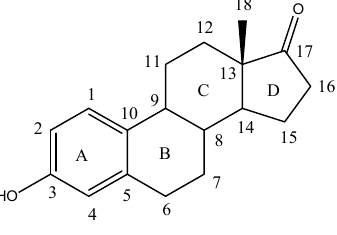
Figure 1. Chemical structure of Estrone.